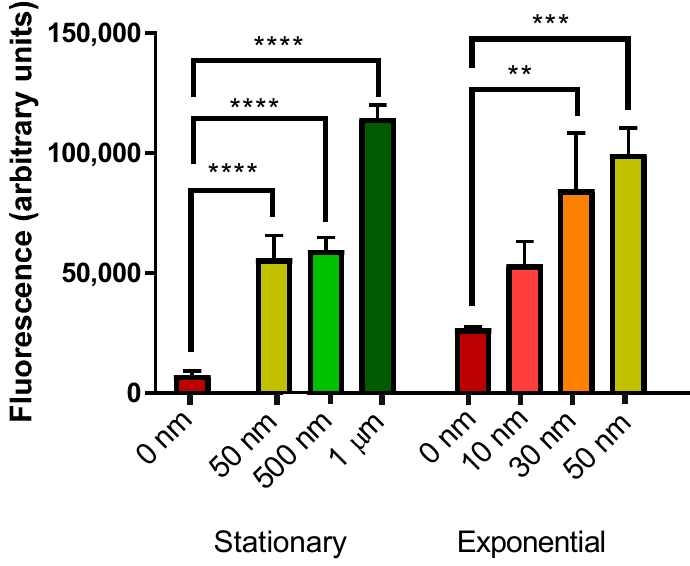
Figure 5. Measurement of mCherry fluorescence of BY4743 [pYHSRed1] cells in stationary and exponential phase growth treated with fibrillar A β 42 . Data are shown as mean ± SEM of triplicate measurements; ** p > 0.01, *** p > 0.001, **** p < 0.0001.